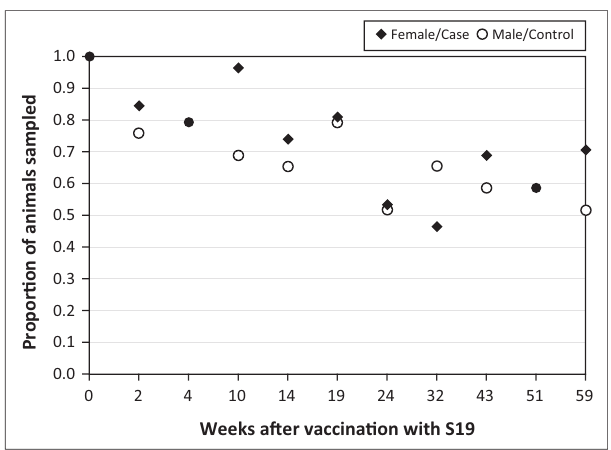
FIGURE 2: Proportion of animals blood sampled over course of